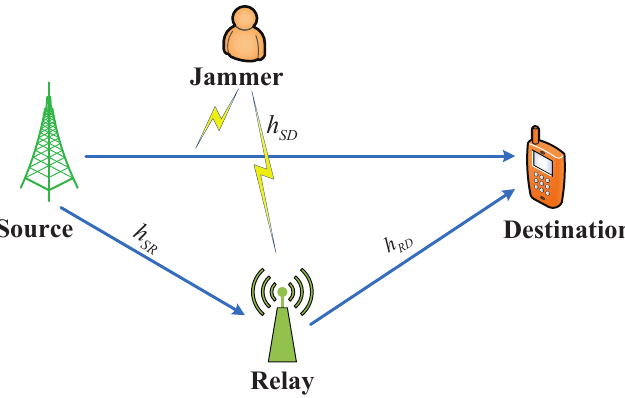
Figure 1. The system model of the proposed